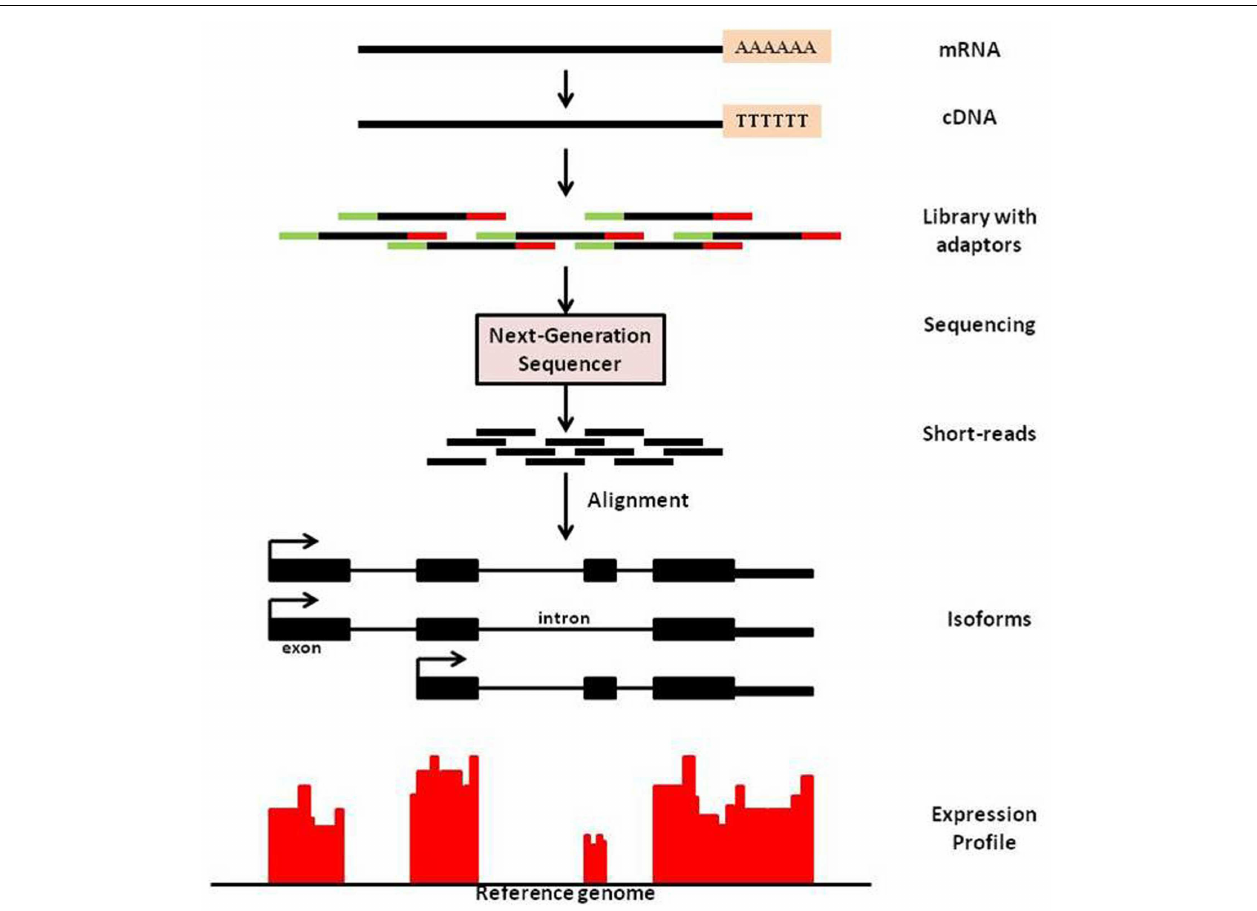
amplification and library construction. New generation high-throughput sequencers enable to read from these fragments and these reads are then mapped to the genome of interest. Expression measure is then available as counts of reads mapped to that